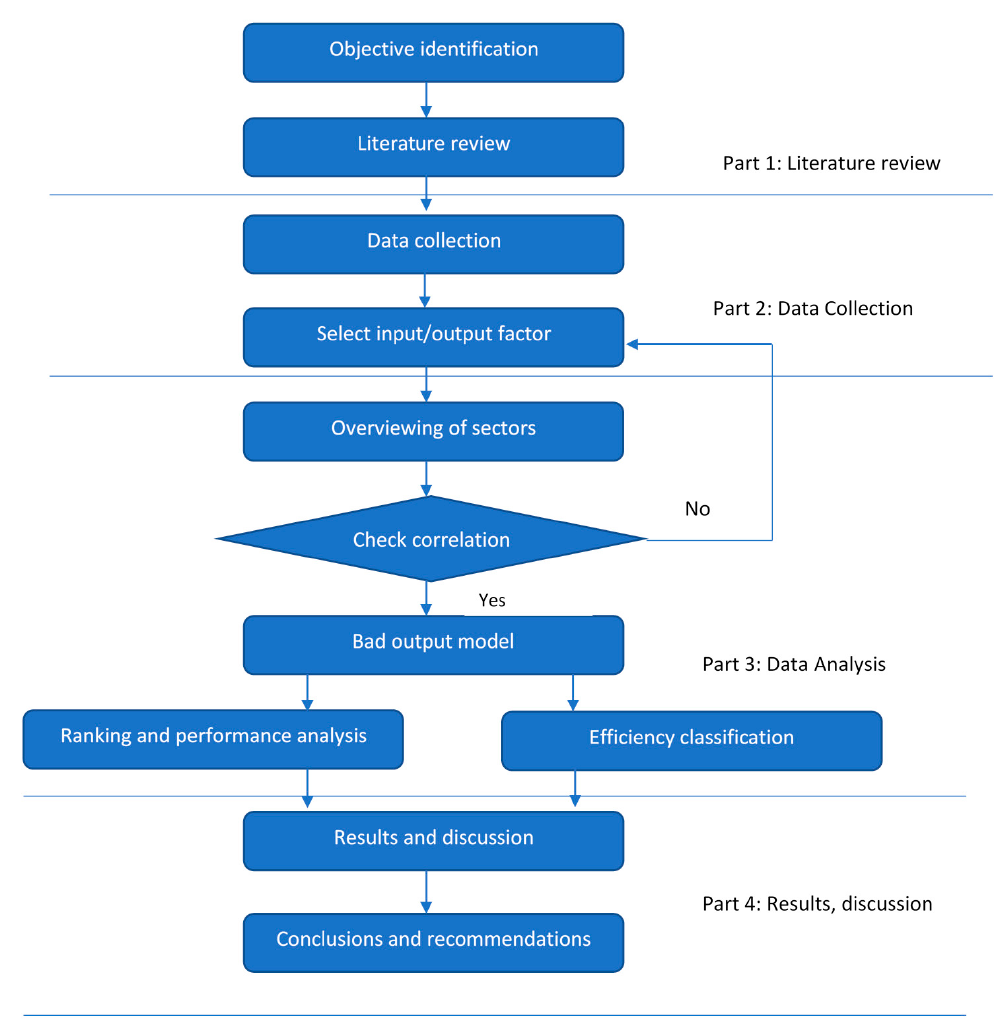
Figure 1. Research